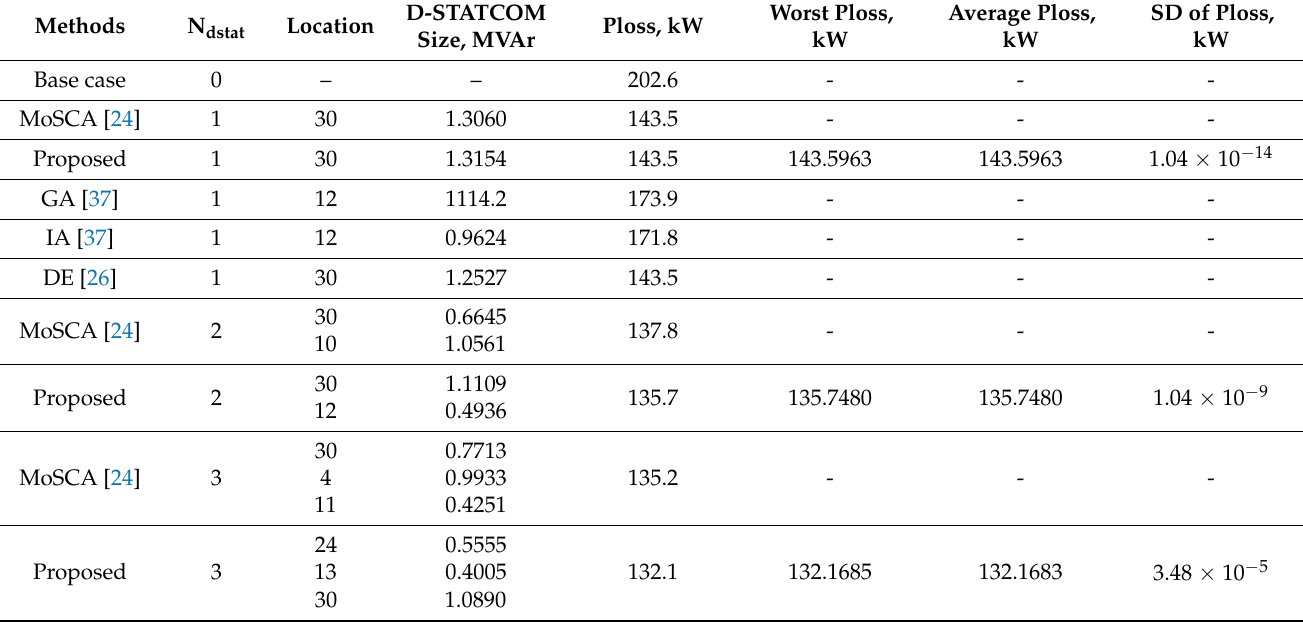
Table 3. Comparison of OADS using different methods for 33-bus PDN.